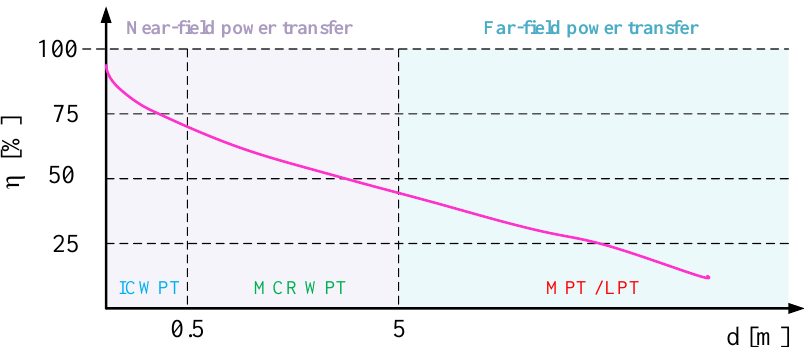
Figure 11. Efficiency of wireless energy-transfer systems depending on the distance between the transmitter and the receiver.